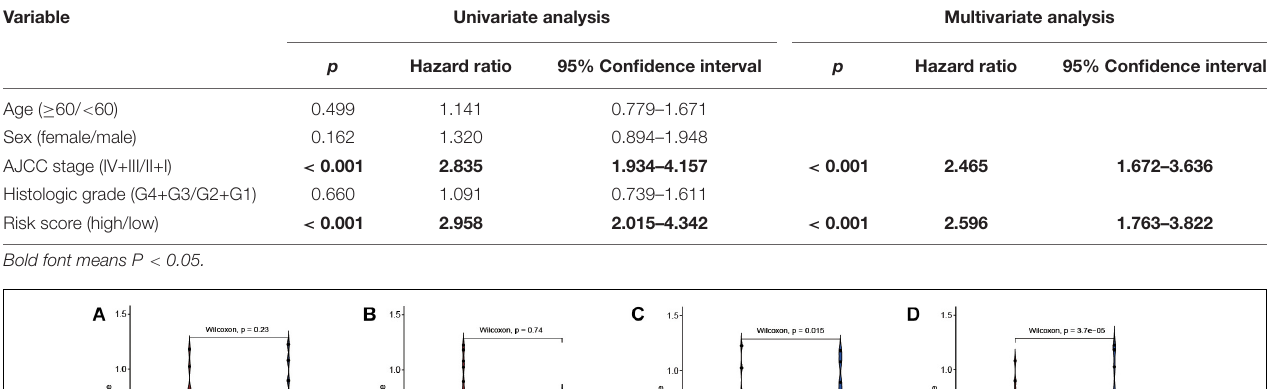
TABLE 5 | Univariate and multivariate Cox regression analyses in the entire group. Variable